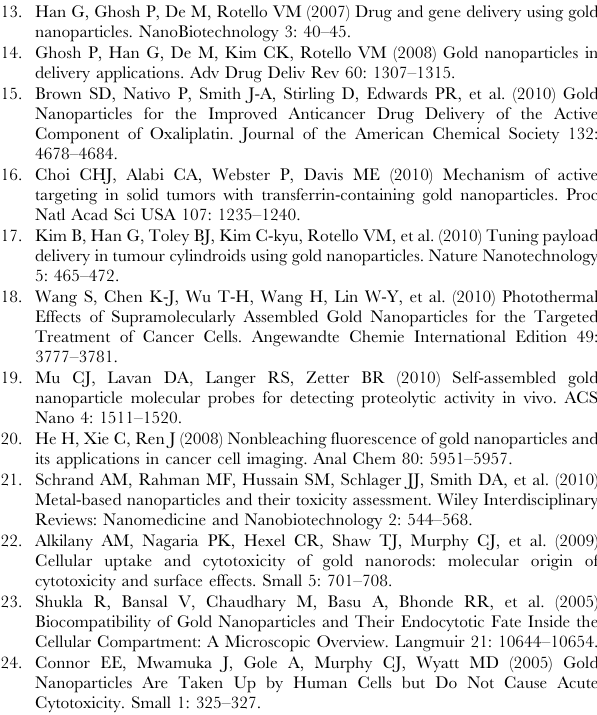
Figure S2 Representative TEM images of (A) 15 nm and (B) 80 nm AuNPs mixed with the Drosophila food. Figure S3 Quantitative analysis of TUNEL positive nuclei relative to TES (top) and TNN experiment (bottom). Experimental points represent the average of data from 20 microscopic fields of 3